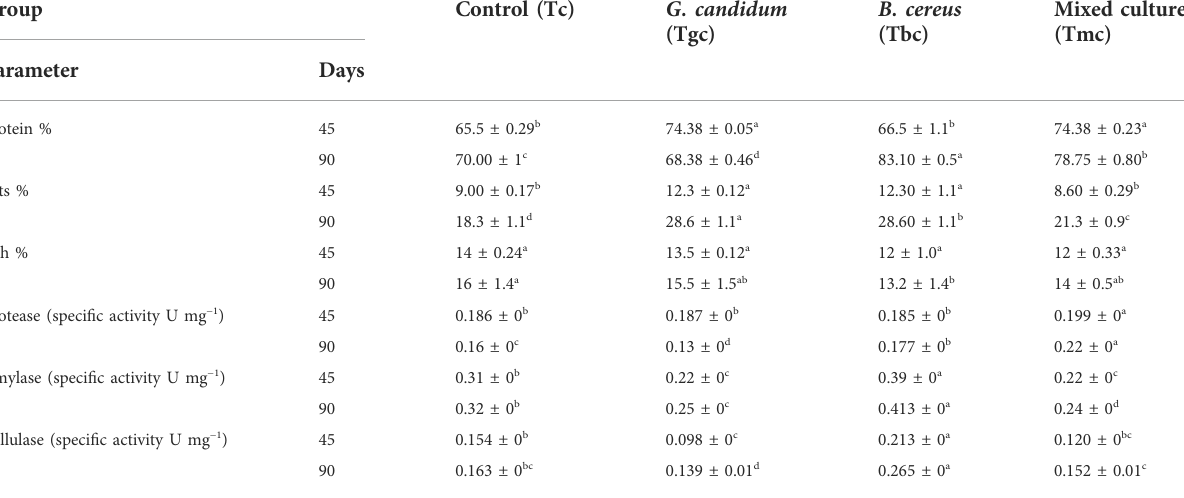
TABLE 3 Impact of feeding probiotic microorganisms (10 9 CFU/gm diet) in single and mixed culture on intestinal enzyme activity and body dry mass chemical composition of Labeo rohita.